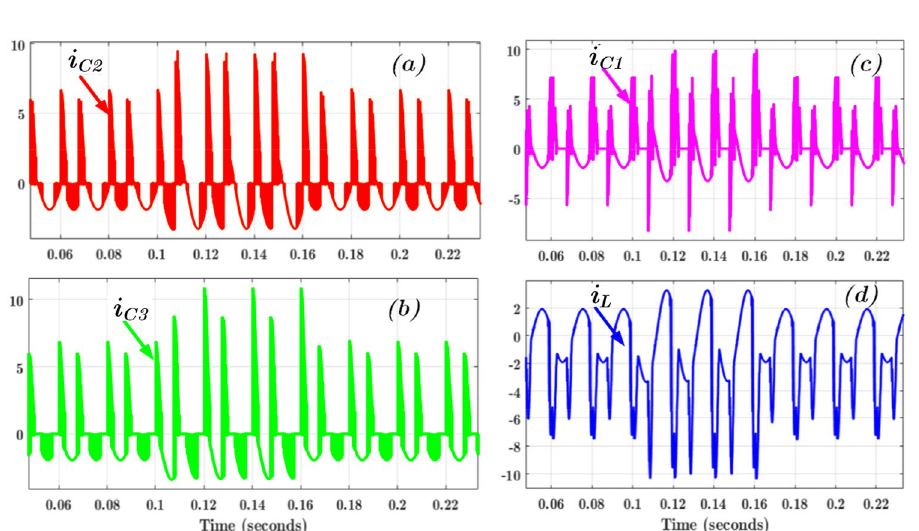
Figure 5. Simulation results during load changes ( a )-( c ) FCs current ( i C1 − i C3 ) and ( d ) inductor current ( i l,ind ).